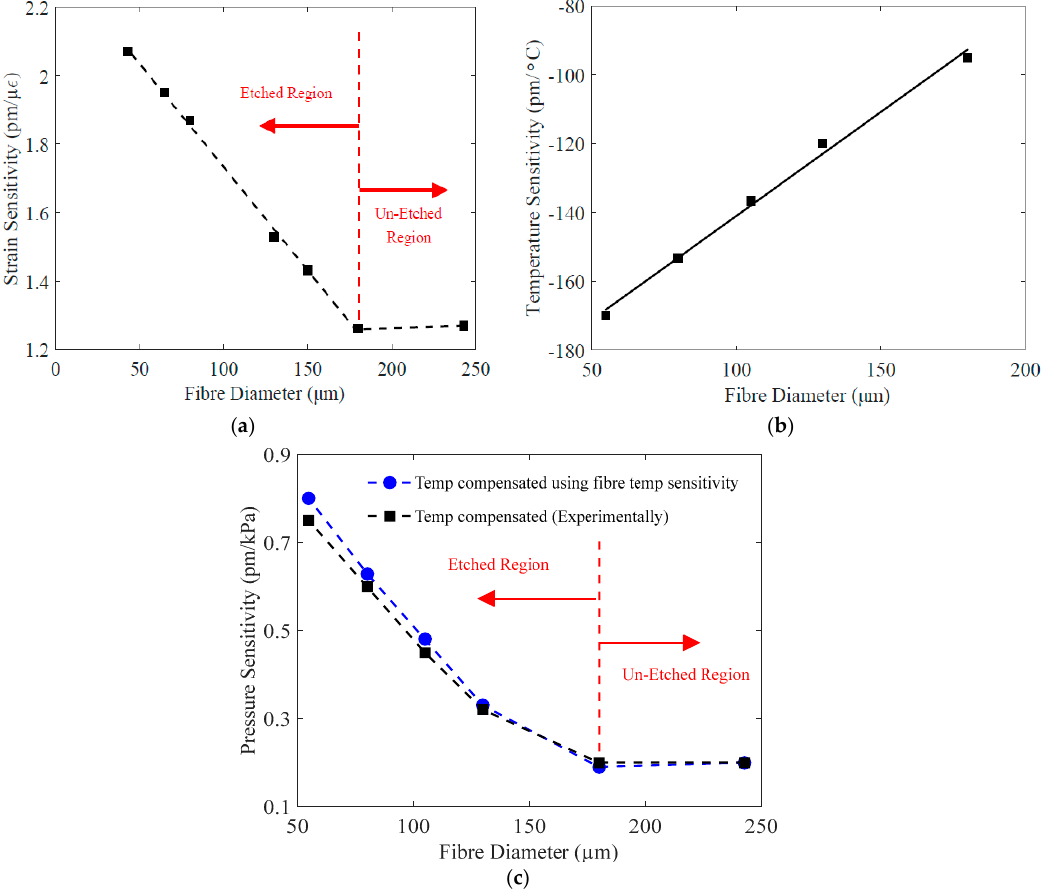
Figure 6. Sensitivity of the PFBG with different fibre diameters. ( a ) Strain; ( b ) temperature; ( c ) pressure.